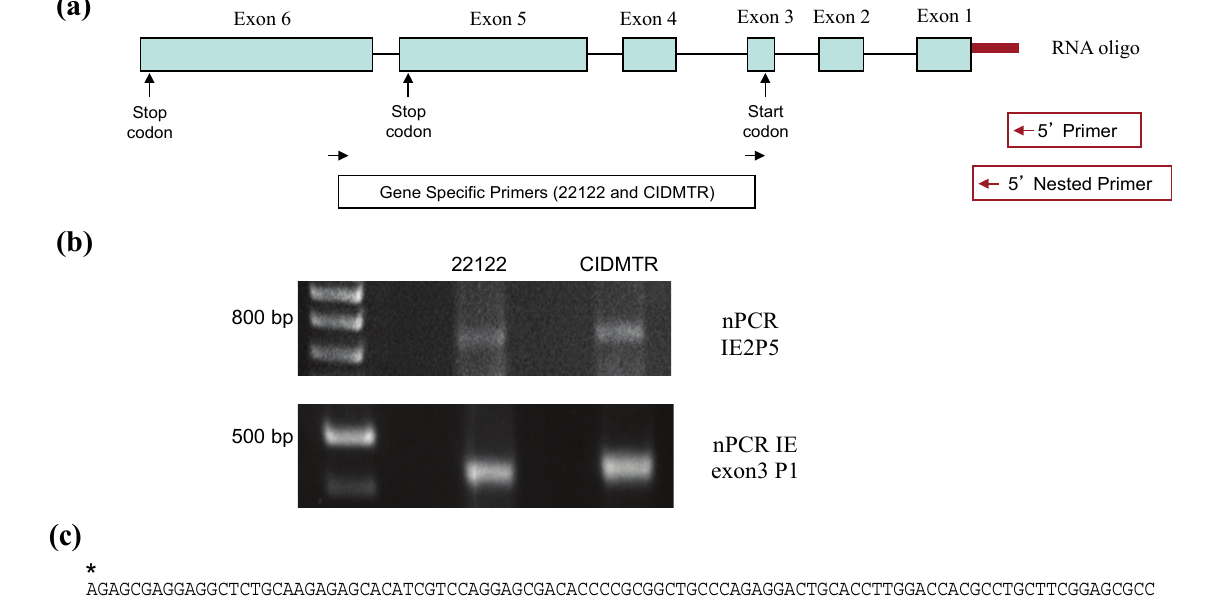
Figure 5. 5' RACE analysis of CIDMTR IE region. ( a ) Schematic of IE gene indicating primers pair used in RACE. ( b ) nPCR gels for 22122 and CIDMTR using RNA purified under IE conditions. The CIDMTR RACE product is 734 nt compared to 729 nt for the 22122 strain, explaining its slightly higher migration by gel electrophoresis. ( c ) RACE consensus sequence of CIDMTR IE. Exon junctions highlighted in blue. First gray highlighted sequence is co-linear to the start codon for 22122; second highlighted sequence represents putative start codon for CIDMTR IE1/2.